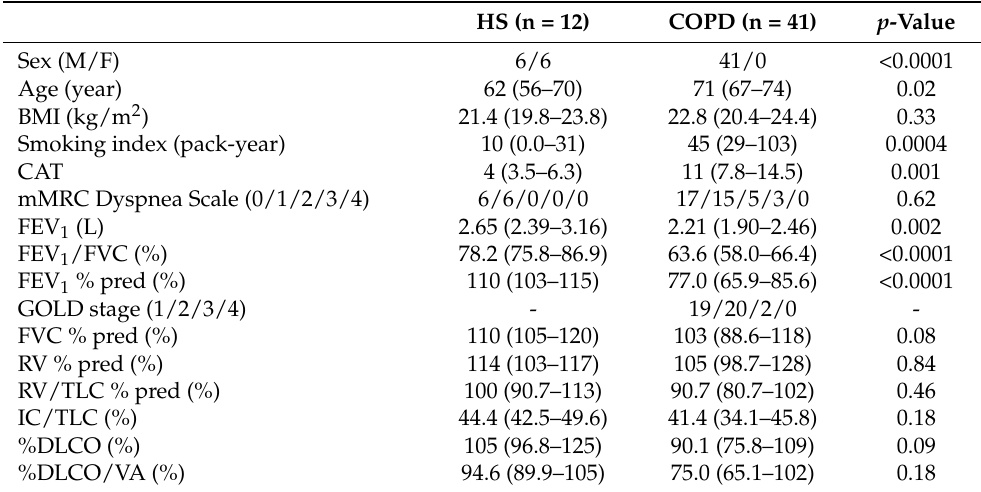
Table 1. Clinical characteristics of healthy subjects and patients with COPD.